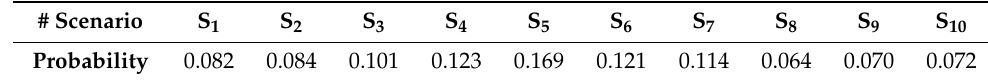
Table 2. Occurrence probability of reduced